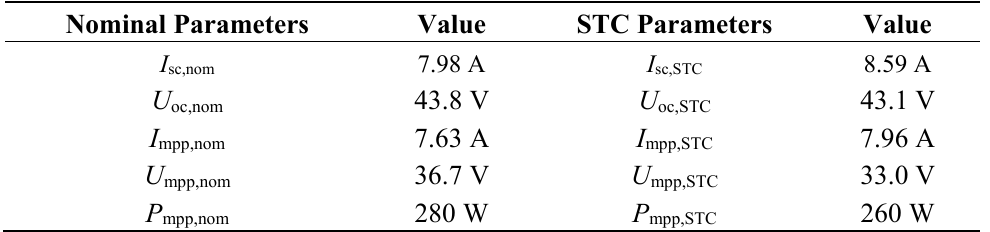
Table 1. Nominal and measured parameters of the tested PV panel at standard test conditions (STC) [24].